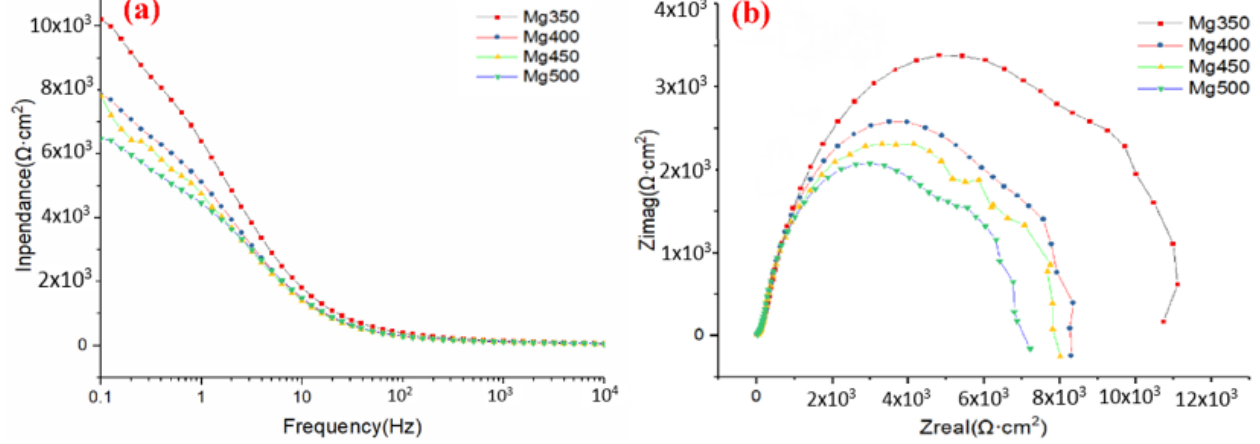
Figure 5. ( a ) Bode plots and ( b ) Nyquist plots of the different annealed conditions in Hank’s solution.